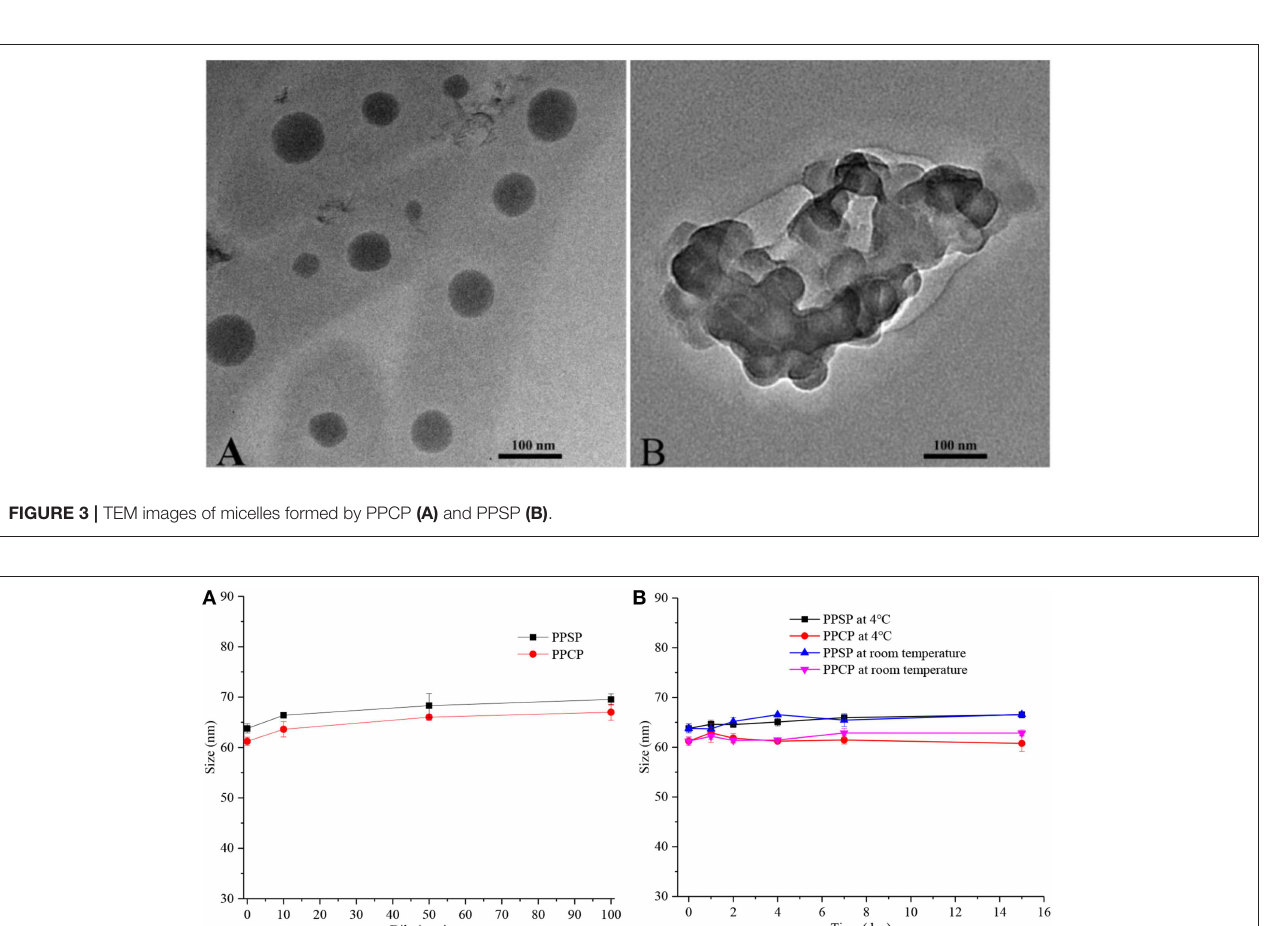
Frontiers in Oncology |